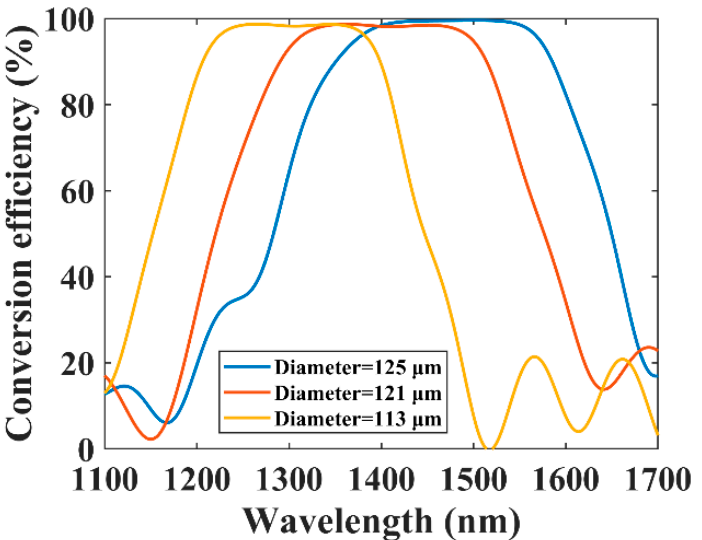
Figure 6. The conversion efficiency of three BLPFGs with a diameter of 113 µ m, 121 µ m, and 125 µ m,